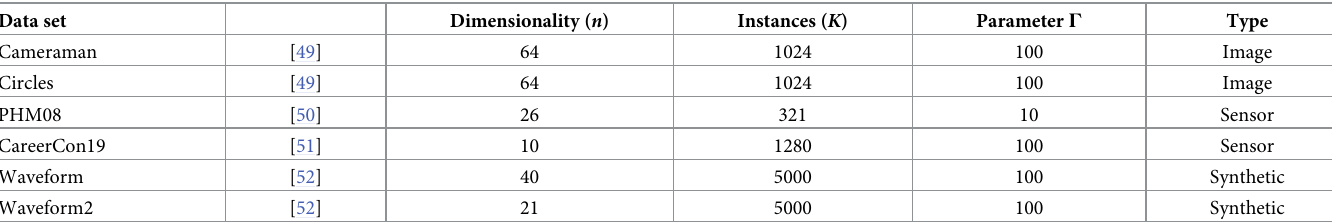
Table 1. Data set properties and training